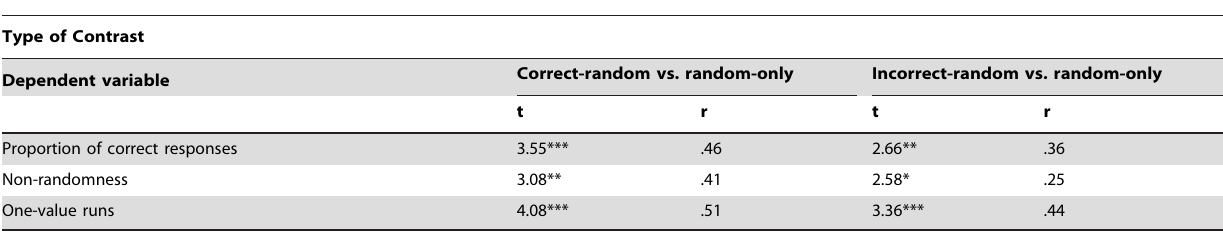
Table 1. t-tests of Contrasts Among Conditions (Experiment